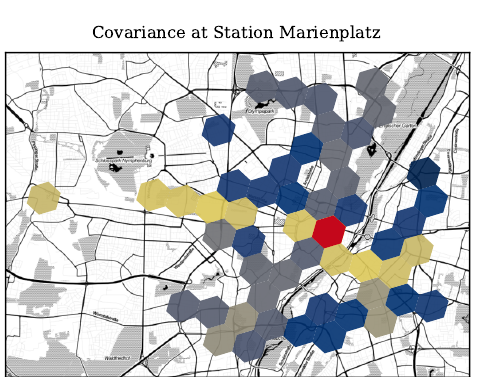
Figure 2. Delay Persistency in Munich and at Marienplatz. When comparing the entire Munich city center to Marienplatz, it, at first, seems surprising that the central location with a very dense time table and high utilization has a lower delay persistency, but Marienplatz also has four tracks while most stations only have two tracks. Delays propagate almost independently on different tracks. This delay propagation is visible from Figure 3.